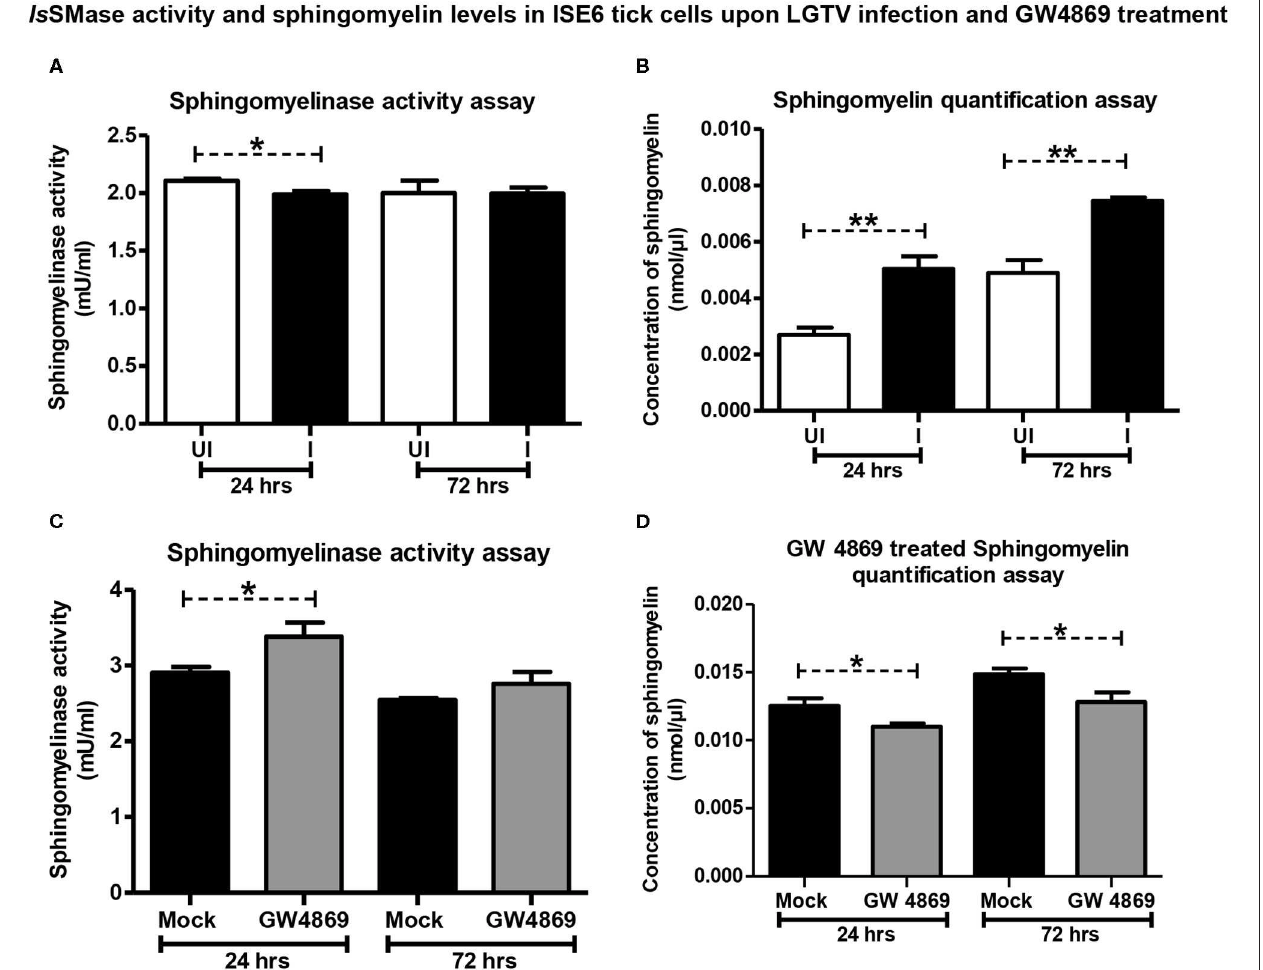
FIGURE 6 | LGTV infection reduced Is SMase activity resulting in induced levels of sphingomyelin lipids but GW4869 treatment restored the infection-mediated effects. (A) Measurement of sphingomyelinase activity in uninfected or LGTV-infected tick cells (A) or mock or GW4869 (1 µ M)-treated, LGTV-infected tick cells (C) at 24 and 72h p.i. is shown. (B) Sphingomyelin levels in uninfected or LGTV-infected tick cells (B) or mock or GW4869 (1 µ M)-treated, LGTV-infected tick cells (D) at 24h and 72h p.i. are shown. White bars represent uninfected (UI) and black bars denote LGTV-infected (I, MOI 1) groups. Mock represents group treated with vehicle DMSO. Both mock and GW4869 inhibitor-treated groups were infected with LGTV (MOI 1) for indicated time points. Is SMase activity and SM lipid levels were measured in milliunits/ml. P -value determined by Student’s two-tailed t -test is shown. The asterisk indicates significance, and * or ** denotes a P -value of less than 0.05 or 0.01,